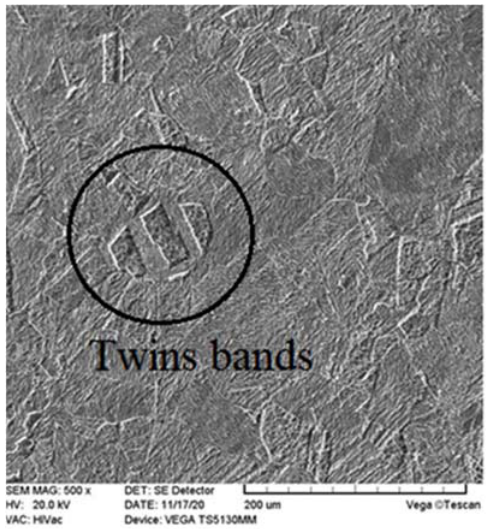
Figure 19. SEM micrograph of the sheet sample produced in the tenth pass by the modified ‐ CSP